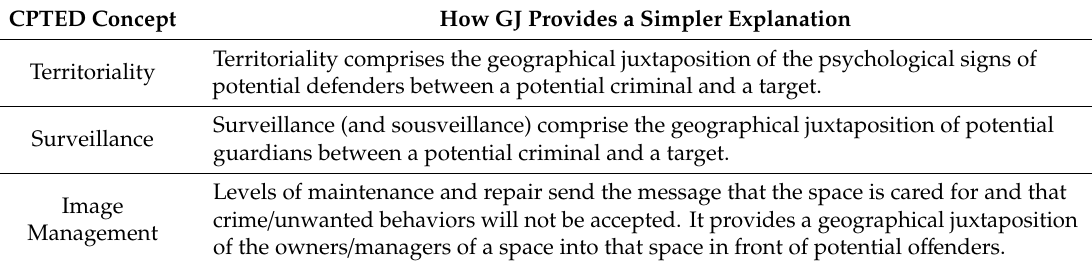
Table 4. Geographical Juxtaposition and other CPTED